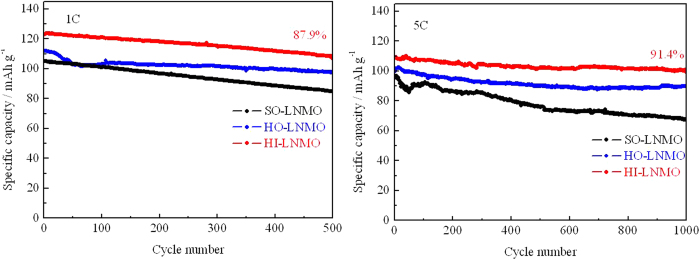
Cycling performance of LiNi0.5Mn1.5O4 with different microstructures rates of 1 C and 5 C.